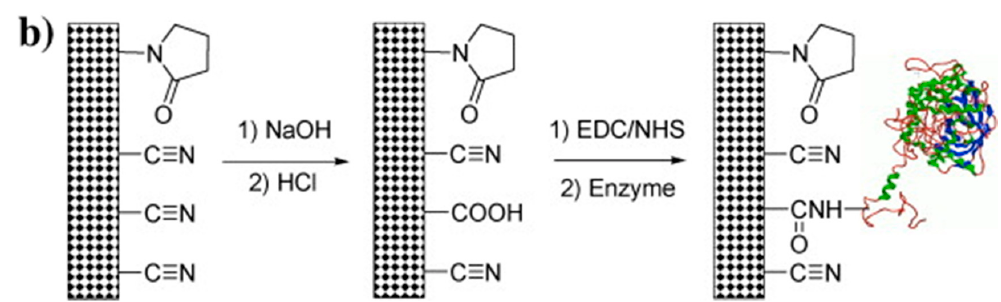
Figure 8. Schematic of EDC / NHS reactions without ( a ) and with ( b ) surface functionalization. Reproduced with permission from [83,88]. Copyright Elsevier, 2019,